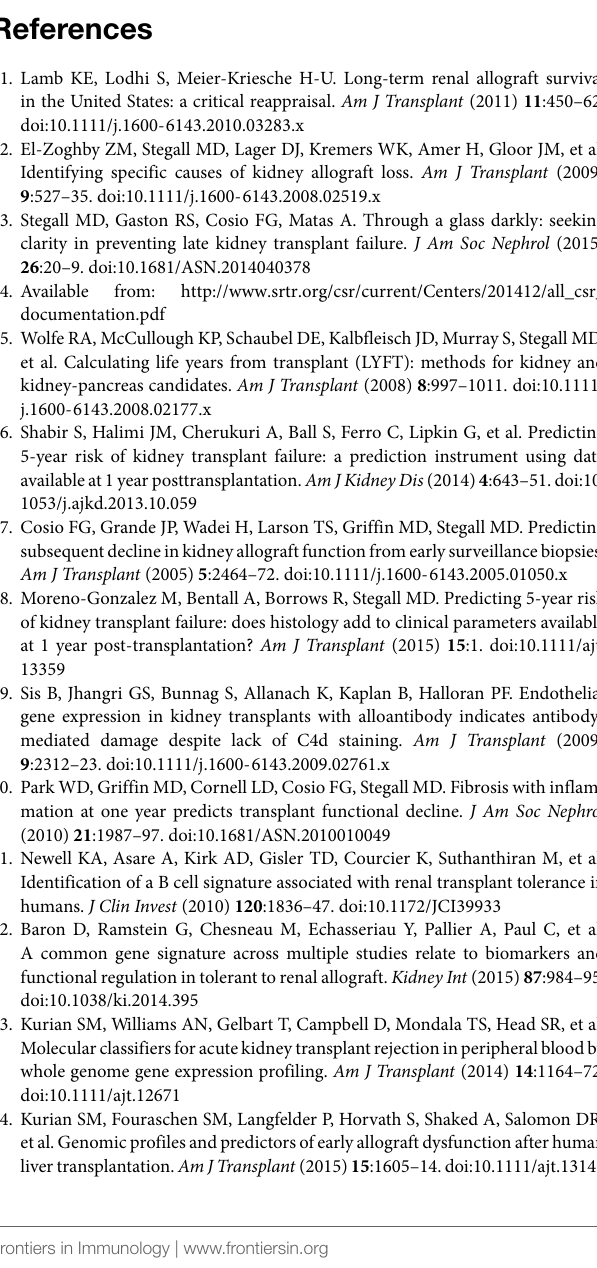
TABLE 1 | Possible approaches to using computational biology to studying chronic renal allograft injury . (cid:15) Comprehensive assessment of subjects (cid:14) Immune system assays (cid:14) Target tissue assessment (cid:15) Long-term studies with serial assessments (cid:15) Biomarkers related to the biology/targeted interventions (cid:14) Omics studies of peripheral blood lymphocytes, serum, plasma, urine, or tissue (cid:14) Detailed alloantibody studies